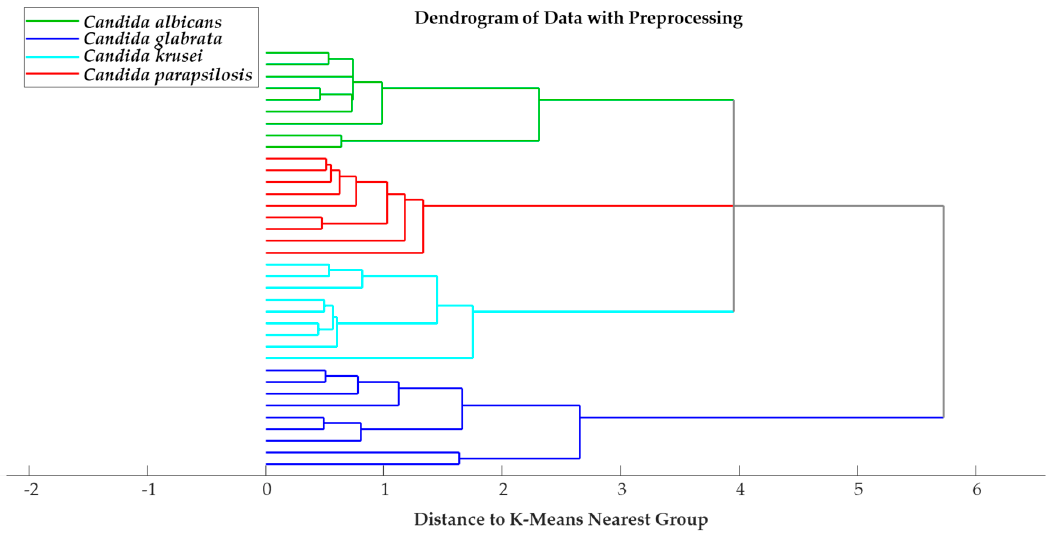
Figure 4. K-means cluster analysis plot for untreated dataset.